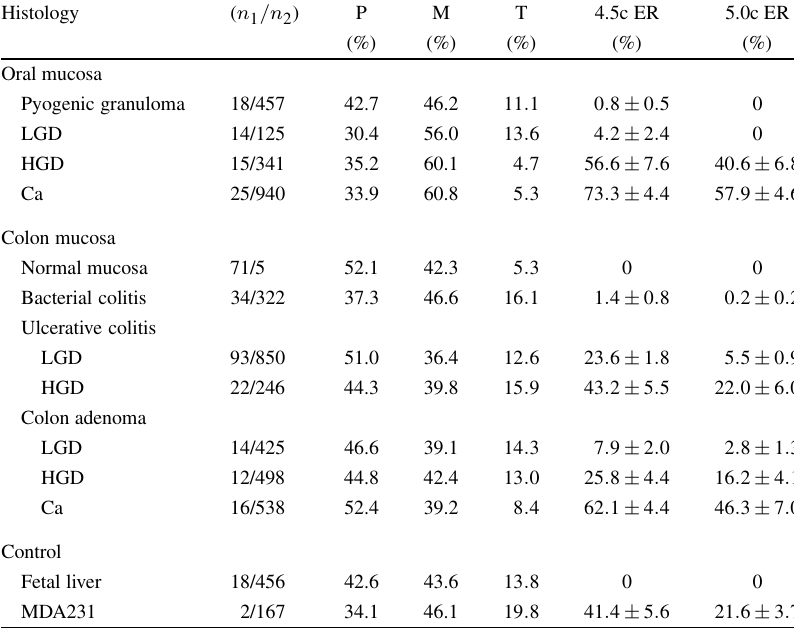
Frequency distribution of DNA content in nuclear